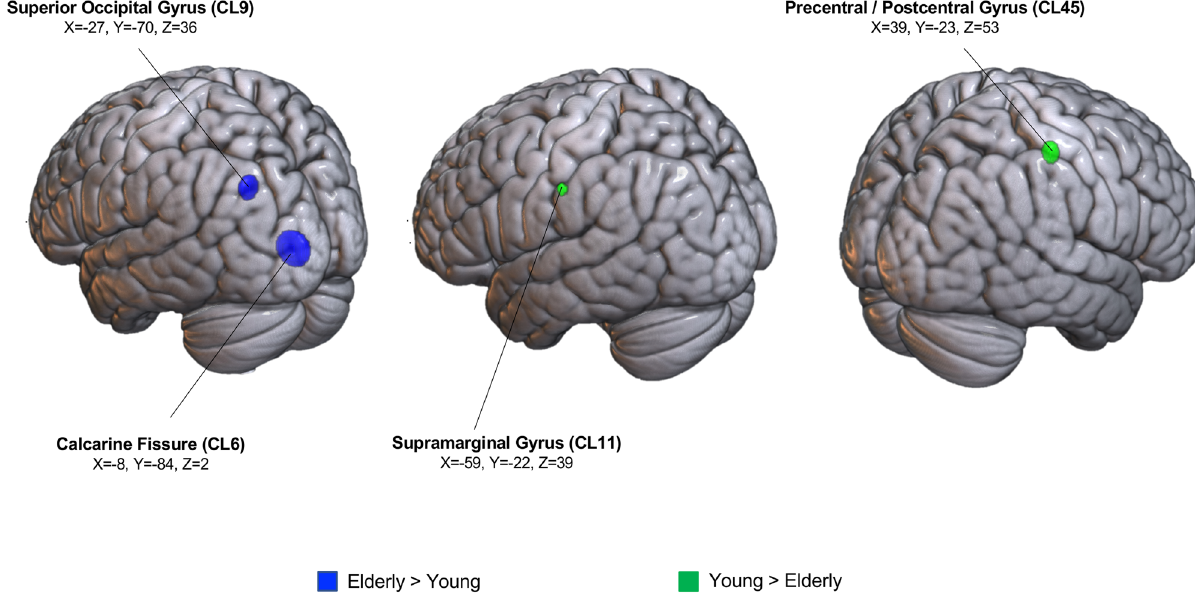
Fig. 1 Clusters showing a signi fi cant main effect of group. Clusters associated with elderly individuals are depicted in blue, whereas clusters speci fi c for young subjects are depicted in green.